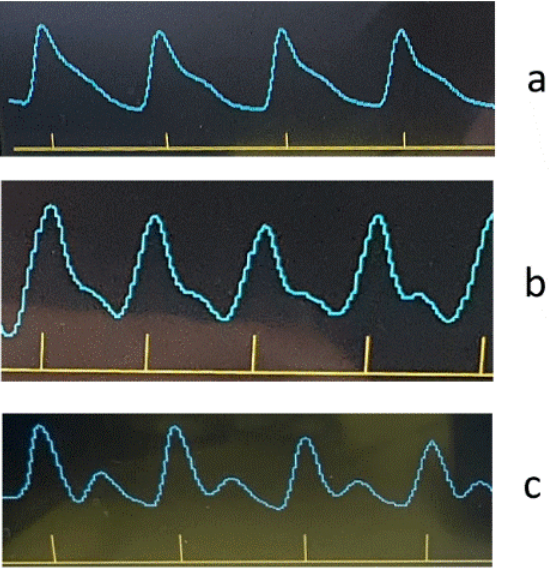
Figure 8. Registered pulse waves of the patients at the beginning of testing.